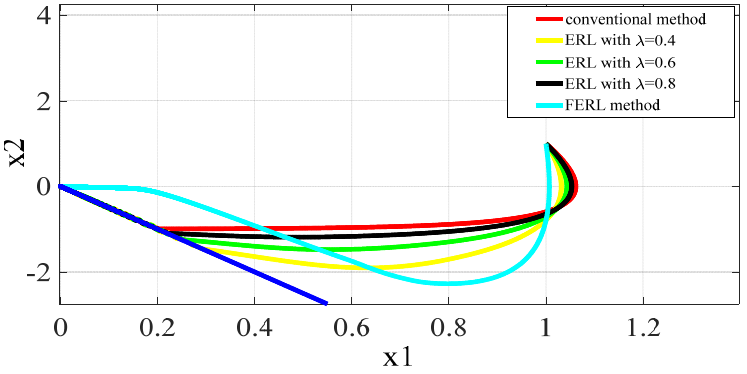
Figure 2. Reaching trajectories in non ‐ linear system.